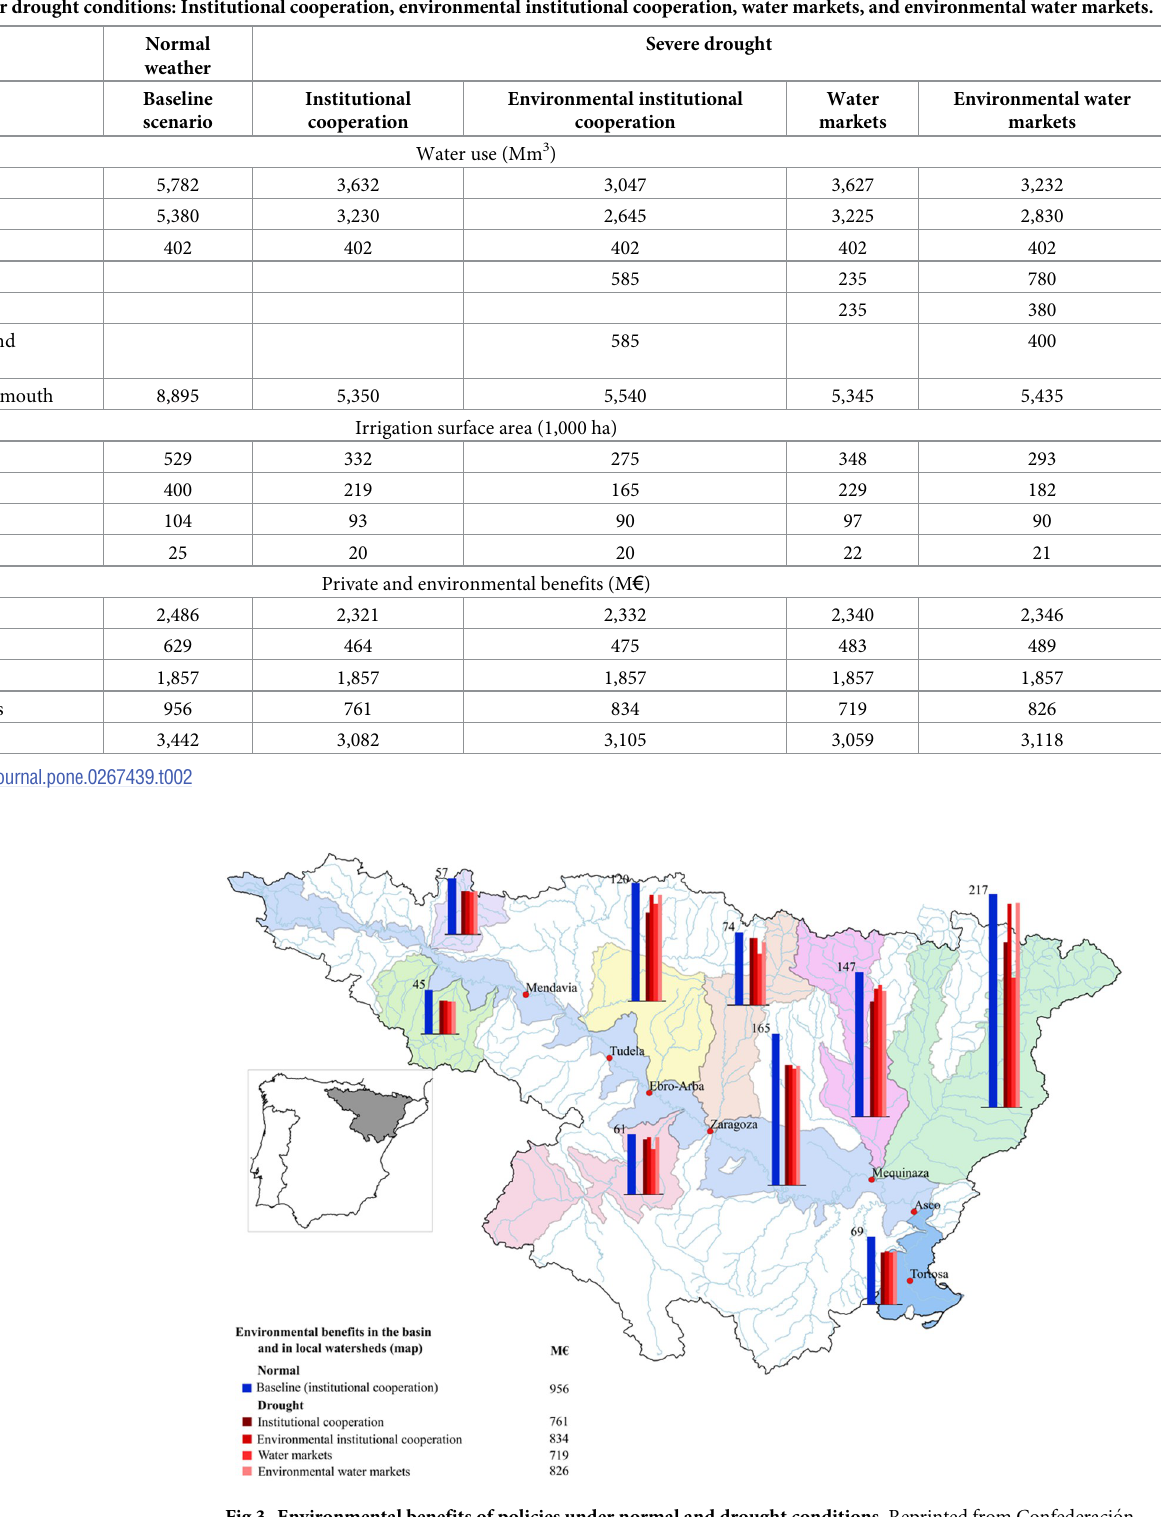
PLOS ONE | https://doi.org/10.1371/journal.pone.0267439 May 5,